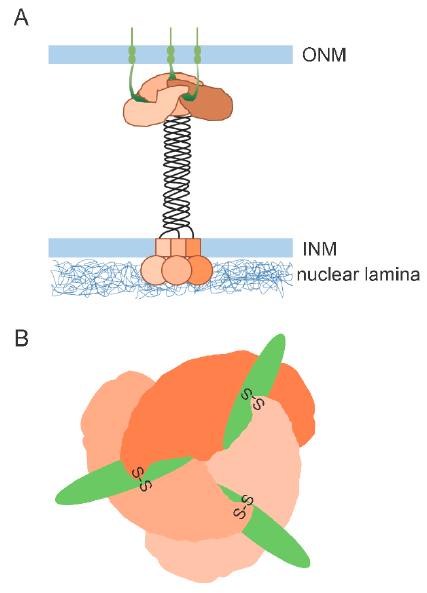
Figure 1. Schematic representation of SUN–KASH interactions based on the results of Sosa et al., and Wang et al. [40,41]. ( A ) A schematic representation of SUN molecular structure with KASH peptide. Orange colour represents SUN molecules and green colour represents KASH and transmembrane domains of nesprin proteins; ( B ) The top-down view of the SUN2/KASH domain. Orange colour shows SUN domain of SUN2 molecules and green colour represents KASH domain of nesprin proteins. Each KASH peptide interacts with the KASH lid of one SUN2 protomer and the beta-sandwich of the neighbouring SUN2 protomer. SUN, Sad1 and UNC-84 homology domain proteins; KASH, Klarsicht, Anc1, and Syne1 homology domain proteins.